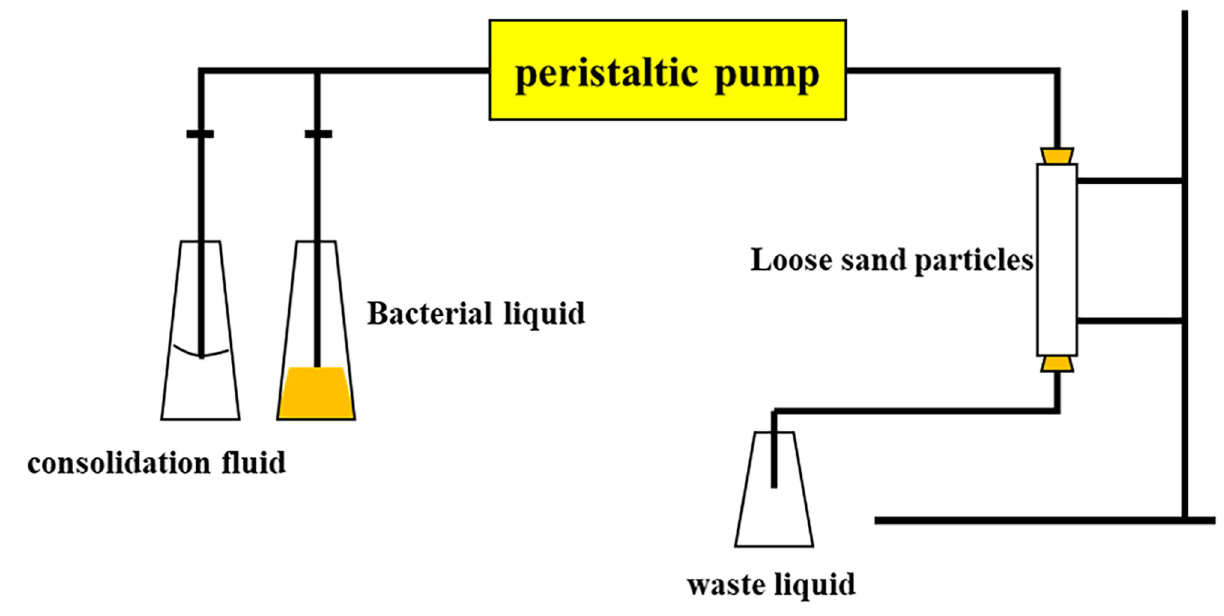
Fig 5. Injection method.